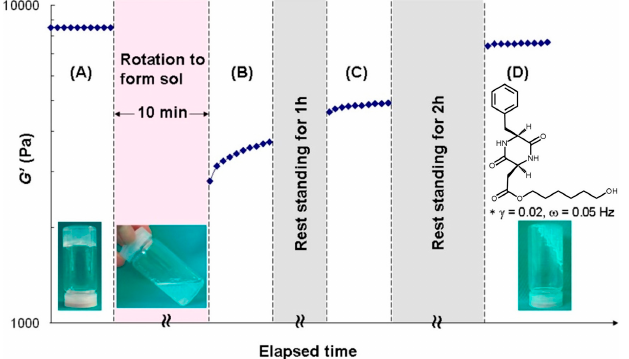
Figure 9. Time-dependence of the storage modulus. The sample was prepared from cyclo ( L - O - hydroxyhexylaspartyl- L -phenylalanyl) in an ethanol/water mixture (20% ethanol/80% water) at 20 g·L − 1 . Image adapted with permission from reference [52]. Copyright 2013 American Chemical Society.